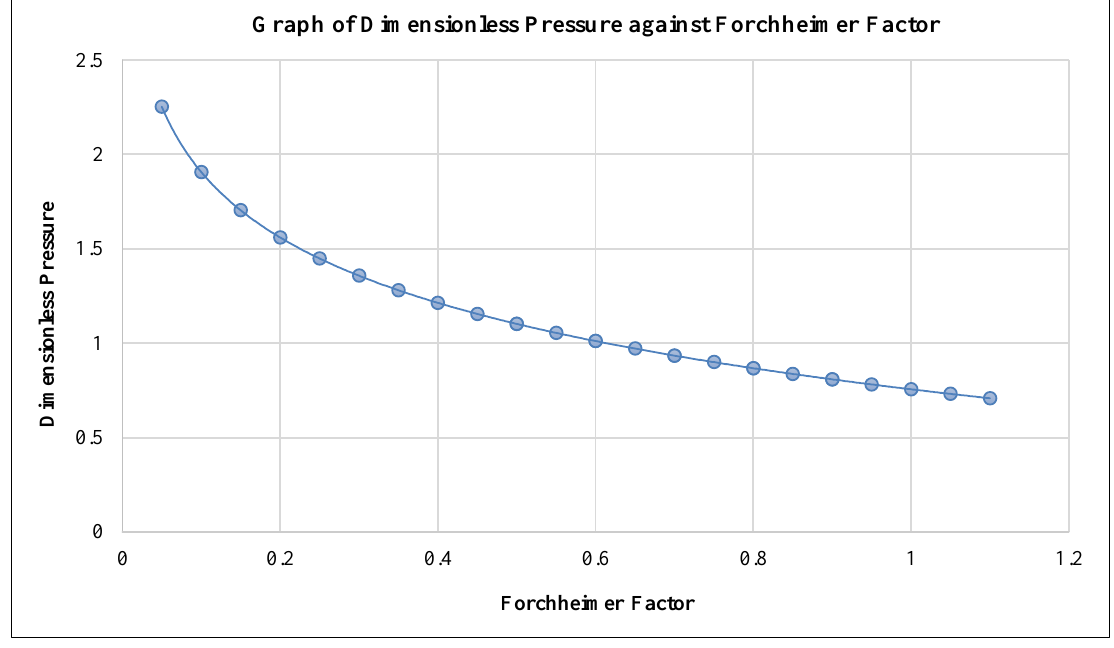
Figure 2. Effect of the Forchheimer Factor on the Dimensionless Pressure